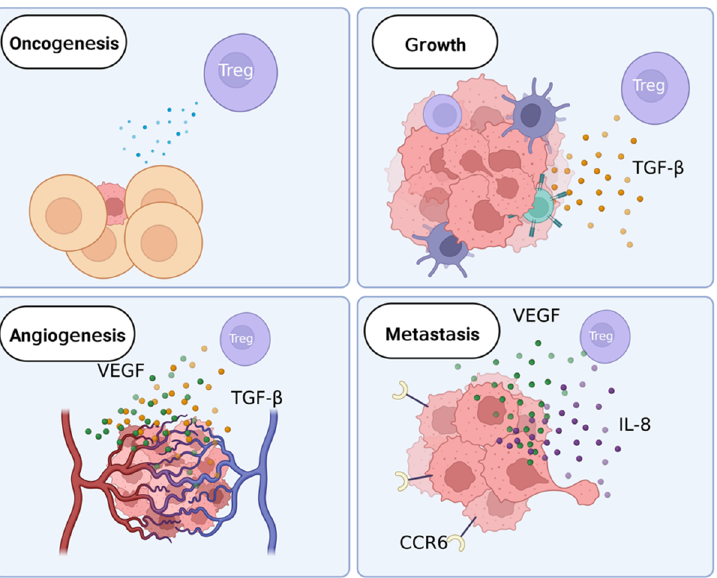
Figure 3. The role of Tregs in cancer development. Tregs may influence early cancer growth via unknown means. In breast cancer, another solid cancer, the presence of Tregs reduces the chance of cancer cells becoming invasive [45]. During cancer growth, tumors recruit immune cells, such as Tregs and tumor-associated macrophages. The main factor secreted by Tregs that assists in proliferation is TGF-β [16]. The secretion of TGF-β encourages growth in cancerous cells and represses anti-tumor immunity. During angiogenesis, TGF-β and VEGF are the primary factors that act on cancer cells [16,44]. These factors are secreted by Tregs and promote the growth of blood vessels and increase the stability of existing blood vessels. In metastasis, VEGF and IL-8 are secreted by Tregs and work to increase cell movement and adhesion [46,47]. Cancer cells also upregulate CCR6 in response to IL-10, which is associated with increased cell mobility [18].